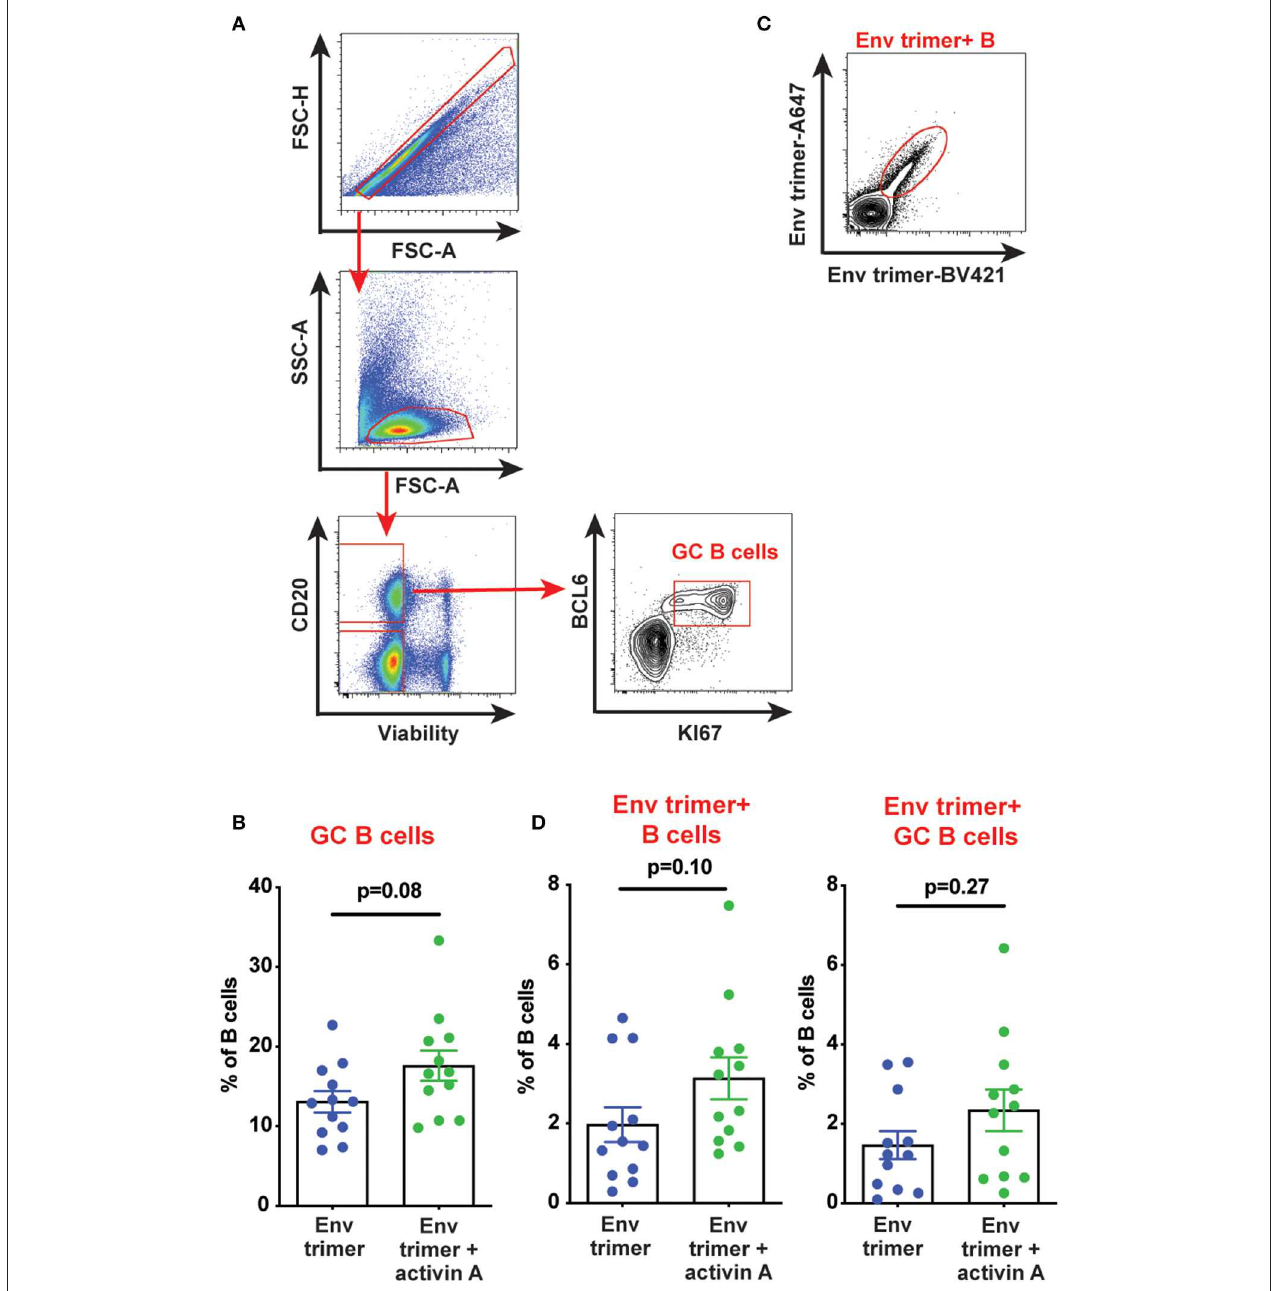
FIGURE 3 | Effect of activin A administration on B cell responses. B cell populations were analyzed by flow cytometry in iliac lymph nodes at week 14. (A) Representative flow cytometry analysis of GC B cells. (B) Graph shows quantitation of GC B cell frequency as percentage of CD20 + live cells. (C) Representative flow cytometry staining of Env trimer-specific B cells. (D) Graphs show quantitation of Env trimer-specific B cell and GC B cell frequency as percentage of CD20 + live cells and BCL6 + KI-67 + CD20 + live cells, respectively. In (B,D) each symbol represents a pool of “right” or “left” iliac LNs from an independent animal. Bars show mean +